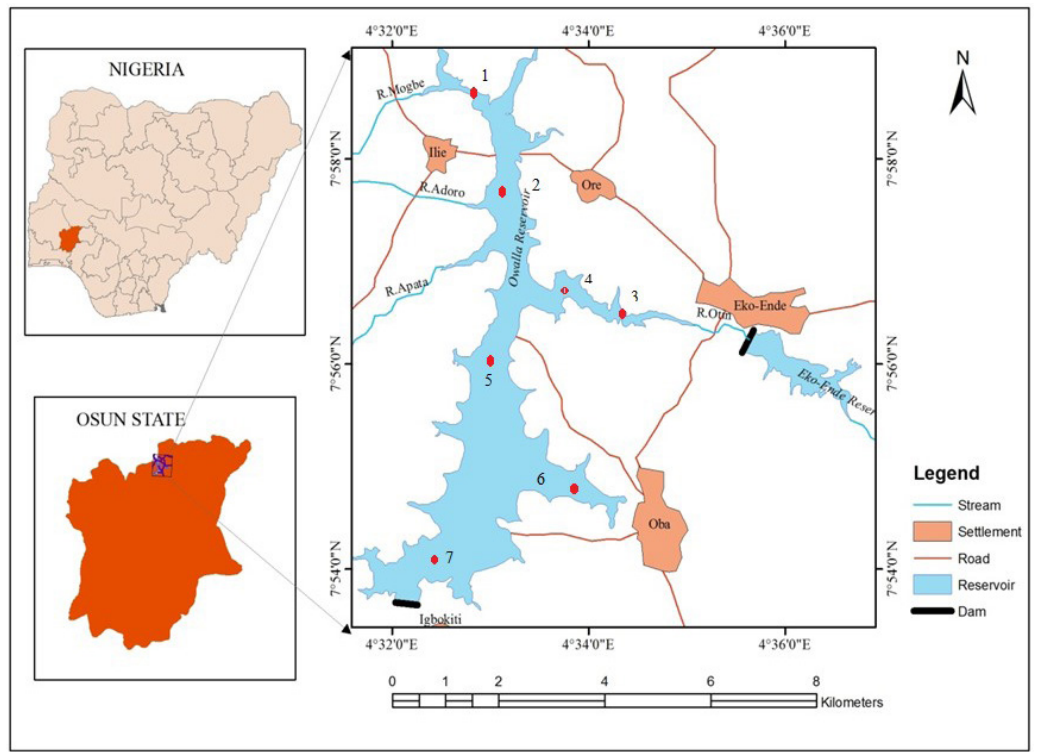
Figure 1. Map of Osun State showing Owalla Reservoir (Omoboye & Adeniyi, 2017) (Stations 2 and 5 were located at the middle basin, Stations 1, 3, 4 and 6 were sited at the inflow while Station 7 was located close to the